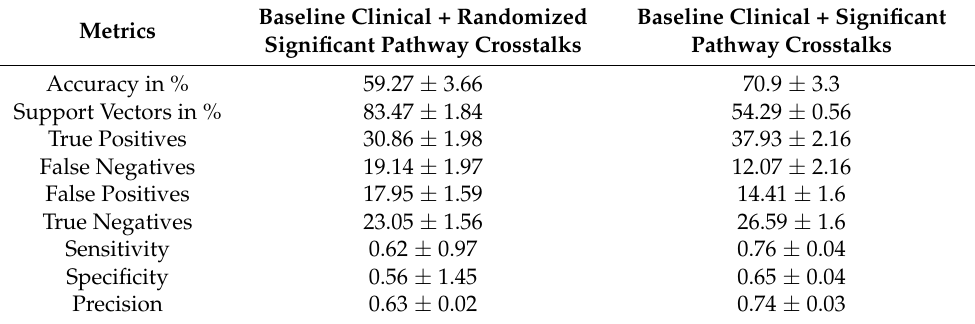
Table 5. Performance of models with randomized pathway cross-talk